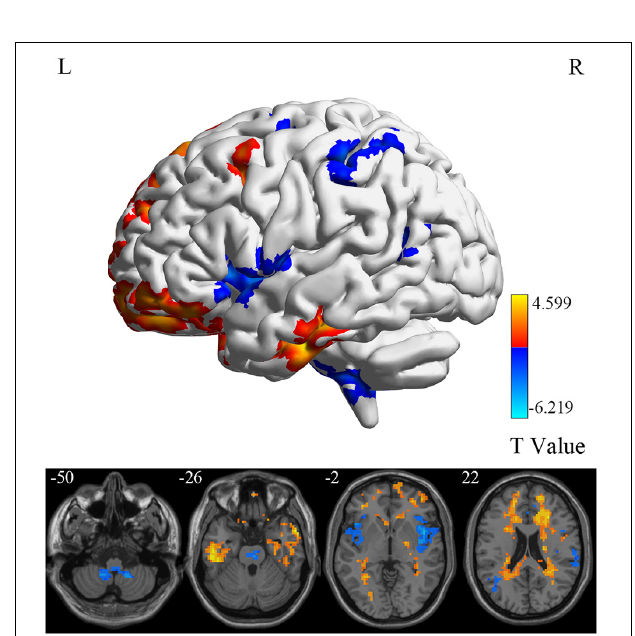
FIGURE 6 | DC differences between MCI reverters and HCs. DC, degree centrality; HCs, healthy controls; L, left; MCI, mild cognitive impairment; R, right.